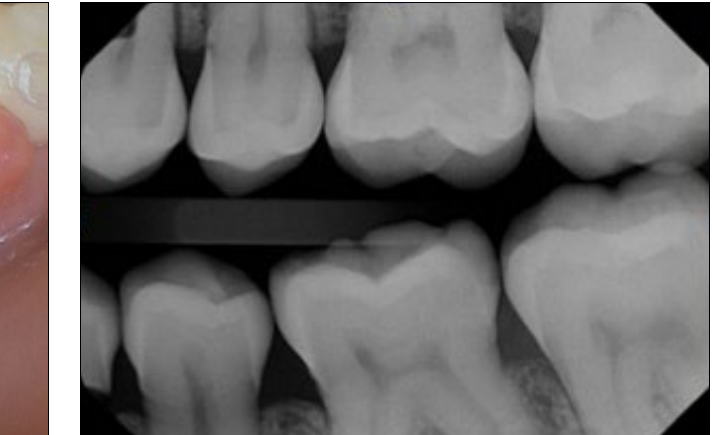
Figure 1b. Bite-wing radiograph of the area showing normal radiographic findings.